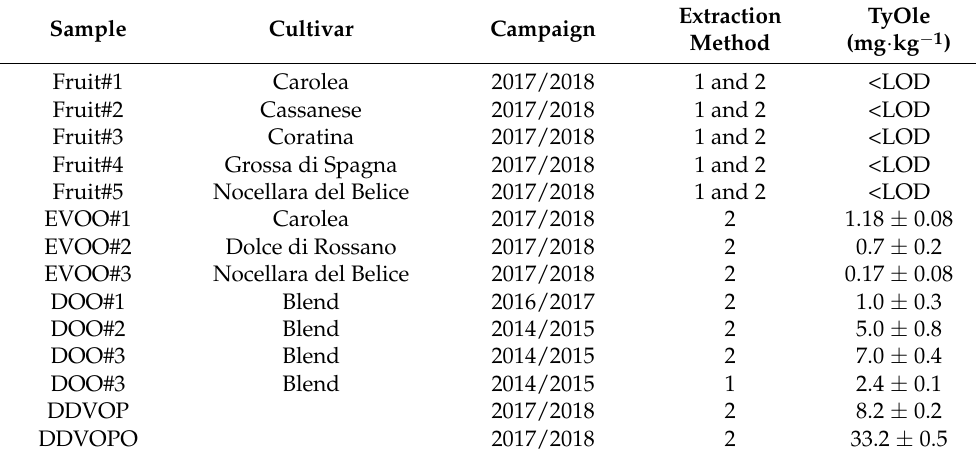
Table 1. Amount of tyrosyl oleate (TyOle) in extracts from olives and olive oils 1 . Sample